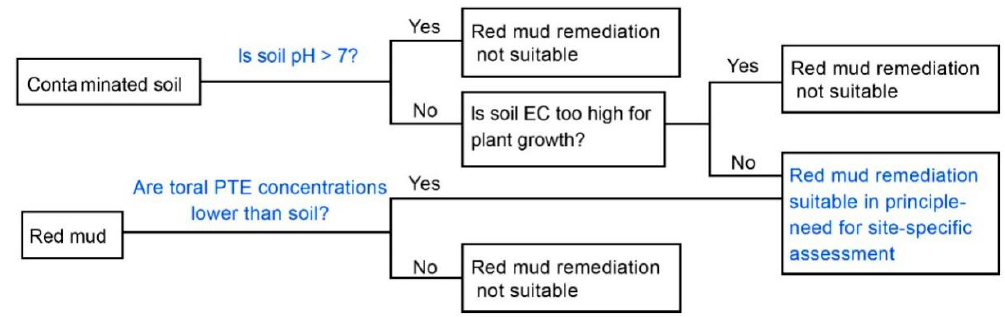
Figure 7. Proposed scheme for assessing the use of RM to treat the contaminated soil. Reproduced with permission from [5], published by Elsevier B.V., 2016.